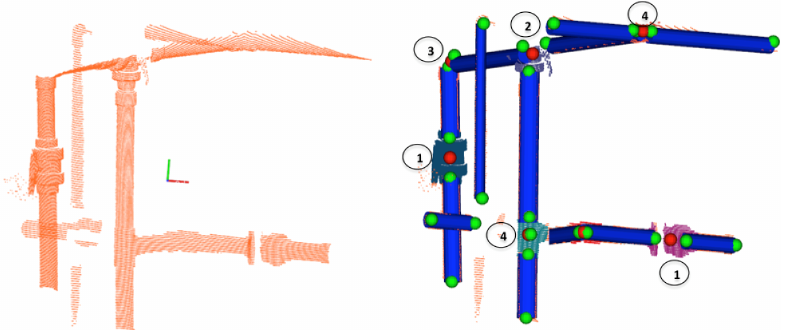
Figure 6. Semantic Segmentation: ( Left ) Input 3D point cloud; ( Right ) Pipes (blue cylinders) with their endpoints (green spheres), and the centroids of the objects to be segmented (red spheres) along with the segmented objects point clouds (colored). The objects 1, 2, 3, 4 represent respectively: a Ball-Valve , a 3-Way-Valve , an Elbow and a R-Tee